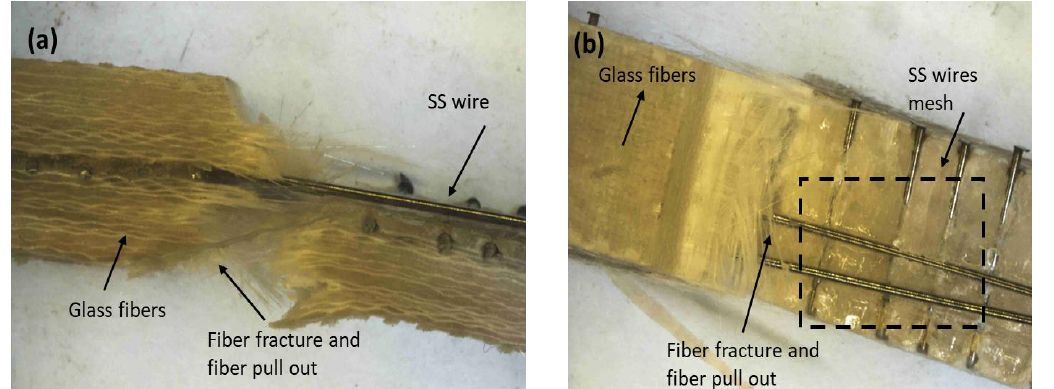
Figure 11. Set A: ( a ) GFRP composite before impact; ( b ) GFRP composite after impact.